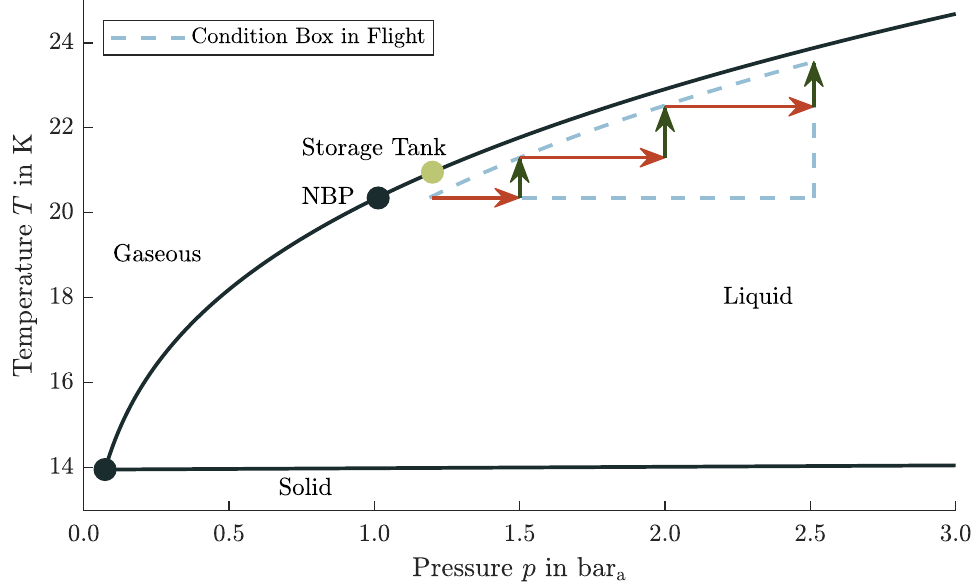
Figure 8. Realistic thermodynamic tank conditions adapted from Mustafi et al. [131]; simplified process for maintaining the subcooling level through isothermal pressurization and isobaric heating for low-pressure pump inlet